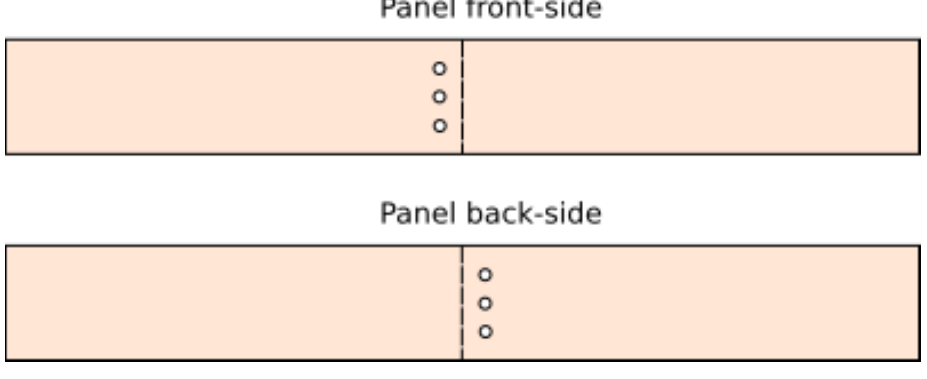
Figure 2. Schematic of the pressure taps on